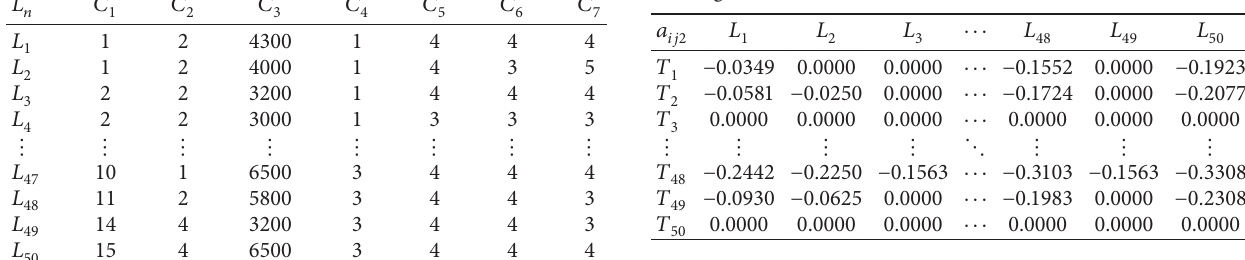
Table 4: Landlords’ evaluation values of housing attributes.